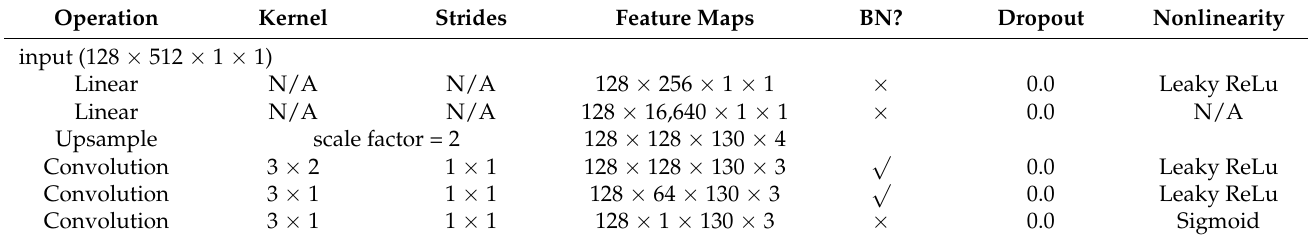
Table 2. Structure of the generator.